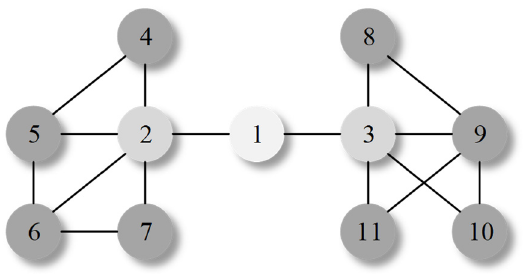
Figure 8. The communication topology G 0 of the UAV swarm.